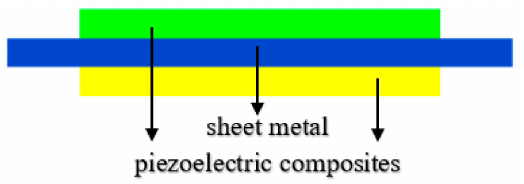
Figure 1. The basic structure of the trilaminar vibrator.